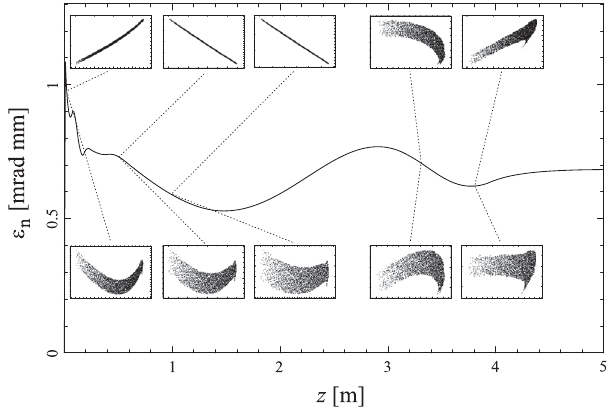
FIG. 18. Emittance of a 90 μ m long slice in the center of the bunch along the beam line. Correlations with the longitudinal coordinate are not significant due to the short length of the slice. The insets depict the radial phase space ( r − r 0 ) at z ¼ 0 . 01 , 0.5, 1.0, 3.3, and 3.8 m. The upper row shows the convergence or divergence of the beam, respectively. For the bottom row, the linear correlation has been removed to pronounce the